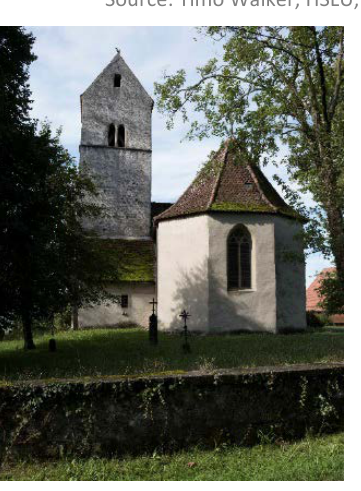
Figure 4: Traditional farmhouse in Kirchbühl Source: Timo Walker, HSLU, 2017